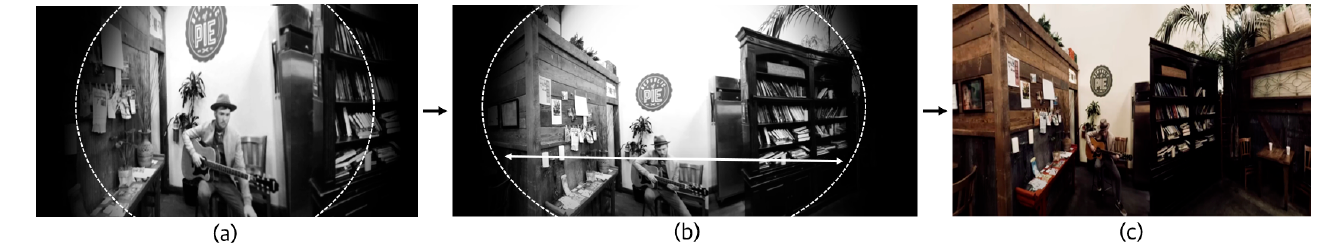
Figure 8. Directed Case using “Gaze angle variation” (video No. 10). ( a ) The space except object A is darkened, ( b ) The screen area is broadened, ( c ) The user can see the scene in which the entire space intended by the director enters the user’s view.4. Development of 360-Degree Eye-Tracking System.